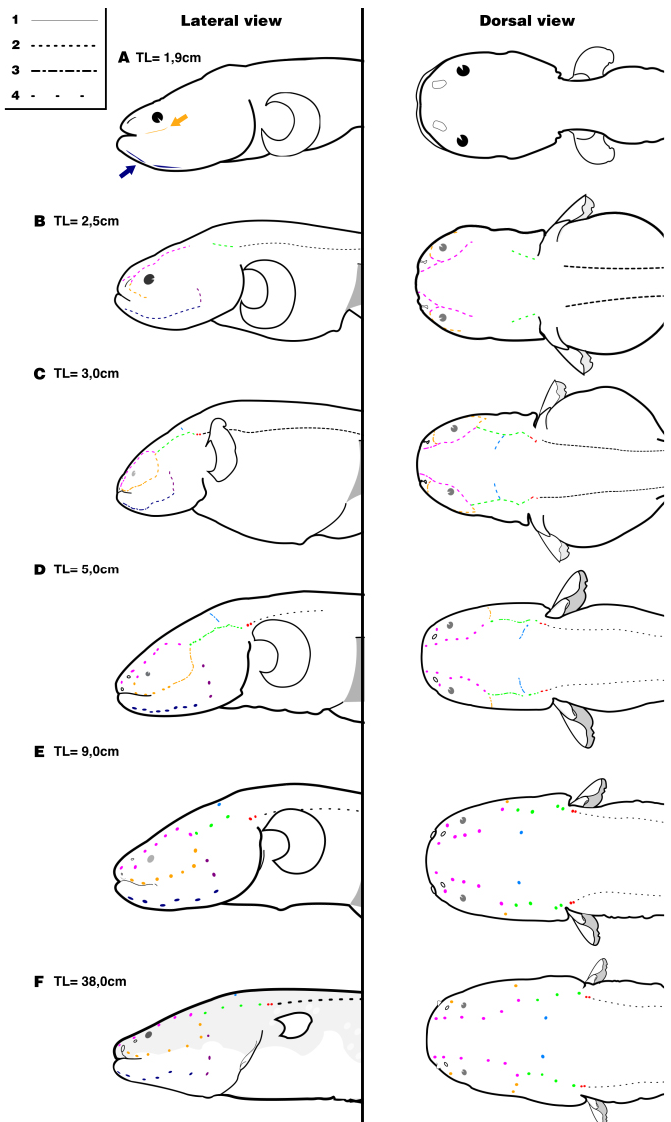
FIGURE 2 | Ontogenetic development of the lateral-line canals in larvae and juveniles of Electrophorus varii , in lateral and dorsal views. A. 1.9 cm TL; B. 2.5 cm TL; C. 3.0 cm TL; D. 5.0 cm TL; E. 9.0 cm TL; F. 38 cm TL. Types of dashes indicate the (1) shallow and short grooves on the skin; (2) deep grooves; (3) segments of grooves start enclosure; (4) pores of canals on the skin. Yellow: infraorbital canal; navy blue: mandibular canal; green: otic canal; purple: pre-opercular canal; pink: supraorbital canal; light blue: supratemporal canal; grey: posterior lateral-line canal of the trunk and; red: otic pit between cephalic and trunk canals. Arrows indicate short grooves of the presumptive infraorbital and mandibular